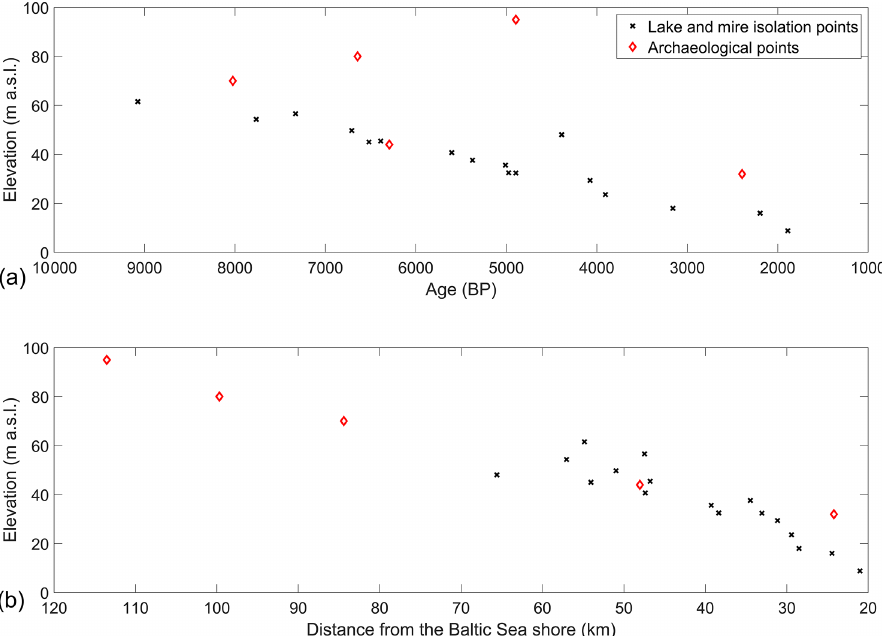
Figure 2. A sample of the data set containing data points along the line from (61 ◦ 0 (cid:48) 0 , 0 (cid:48)(cid:48) , 21 ◦ 6 (cid:48) 0 , 0 (cid:48)(cid:48) ) to (61 ◦ 0 (cid:48) 0 , 0 (cid:48)(cid:48) , 24 ◦ 0 (cid:48) 0 , 0 (cid:48)(cid:48) ) in the WGS84 coordinate system. The distribution of the data points in the elevation–age and elevation–distance domains is presented in the upper and lower panel, respectively. Black cross markers denote the lake–mire isolation data and red diamond markers the archaeological